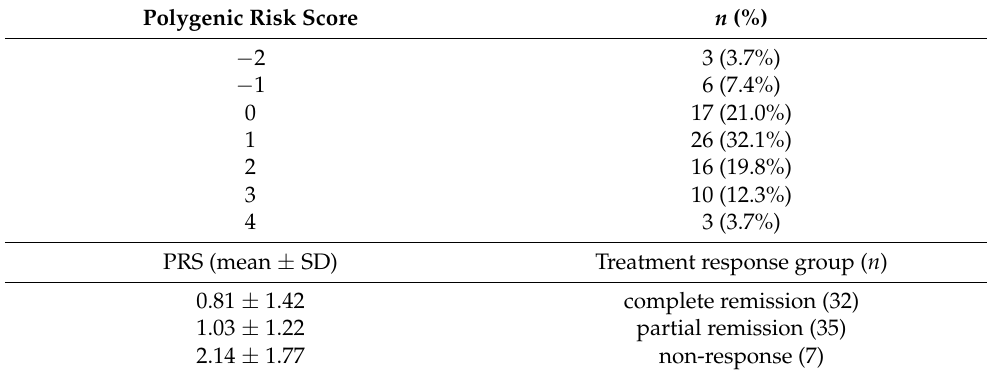
Table 3. Distribution of polygenic risk scores (PRS) and mean PRS per treatment response